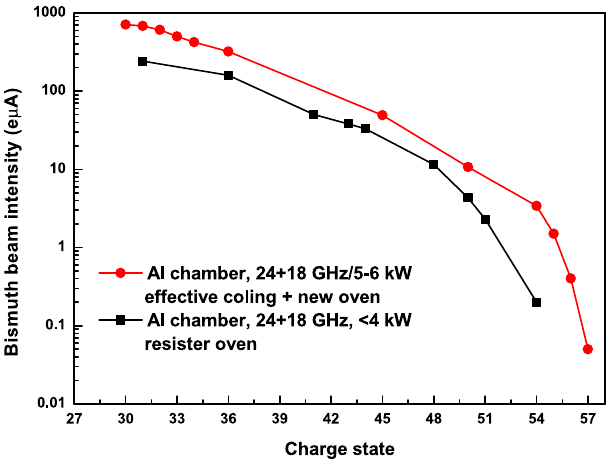
FIG. 14. Bismuth beam currents at the total microwave power 5 – 6 kW with a new oven and compared to those at the power less than 4 kW.